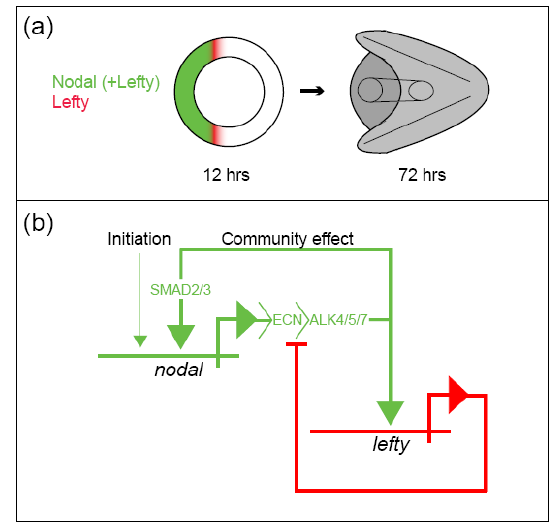
Figure 2. Epigenetic specification of the secondary (oral-aboral) axis of the sea urchin embryo via nodal and lefty . (a) Diagram of the symmetry breaking process in blastula stage embryos that establishes the secondary (oral-aboral) axis of the pluteus. (b) Schematic of the genetic regulatory circuit involving nodal and lefty (genes represented by horizontal lines terminating in bent arrows), through which symmetry is broken by short-range Nodal-mediated activation (a “community effect” [12]) coupled to long-range Lefty-mediated inhibition. Activating interactions are represented by arrows, whereas inhibitory interactions are represented by bars. “ECN”, extracellular